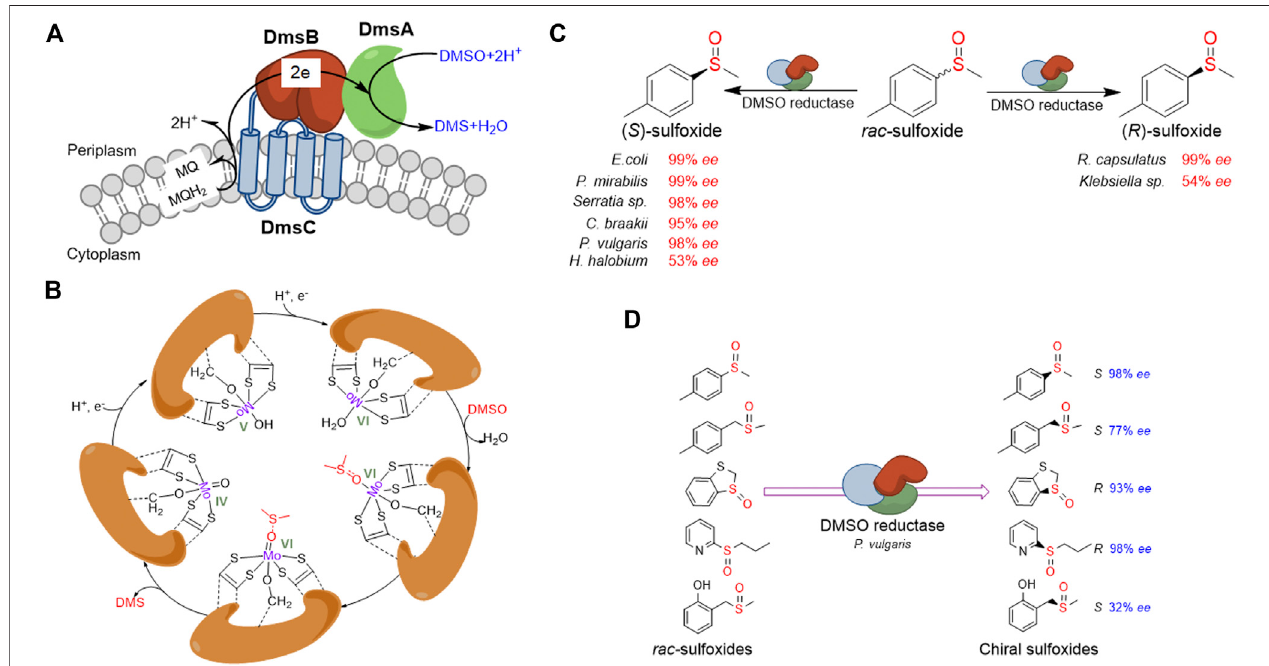
FIGURE 2 | Overview of DMSO reductase and application in chiral sulfoxides preparation. (A) Typical constitution and electron transferring of DMSO reductase in E. coli. (B) Schematic presentation of the proposed catalytic mechanism for the catalytic cycle of DMSO reductase. (C) Representative presentation of DMSO reductases from different organisms shows opposite stereospeci fi city toward the same substrate. (D) Representative presentation of one DMSO reductase shows opposite stereospeci fi city toward different